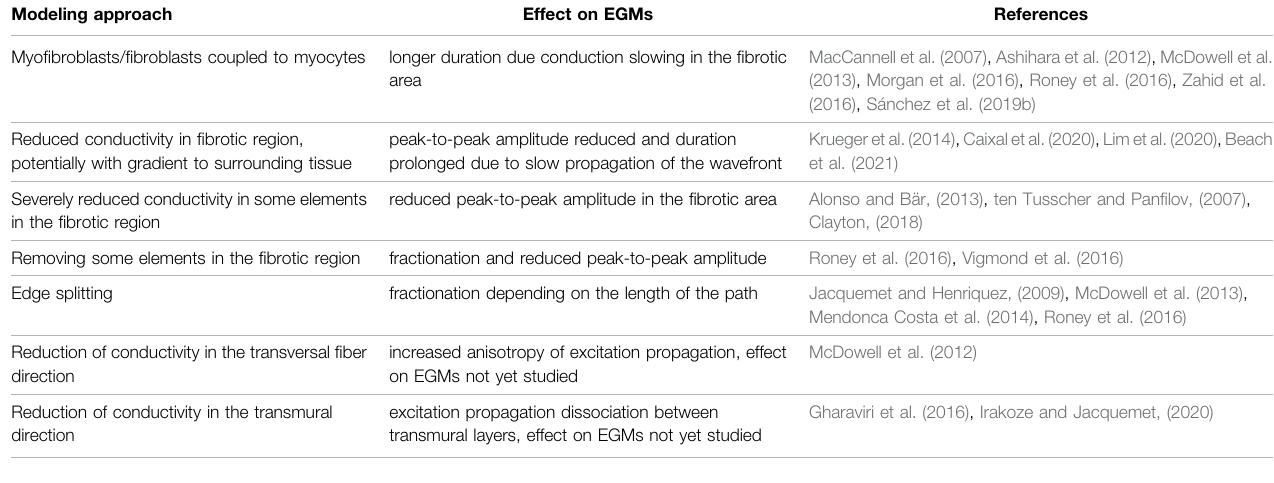
TABLE 1 | Different modeling approaches to represent fi brotic tissue in computational models and their effect on simulated EGMs. Modeling approach